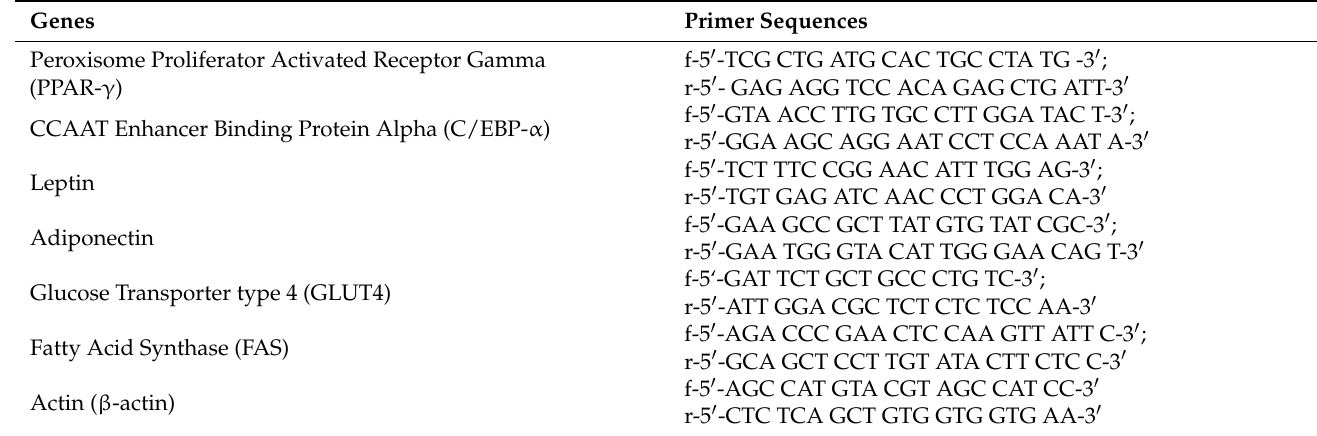
Table 1. Primers used for q-PCR.